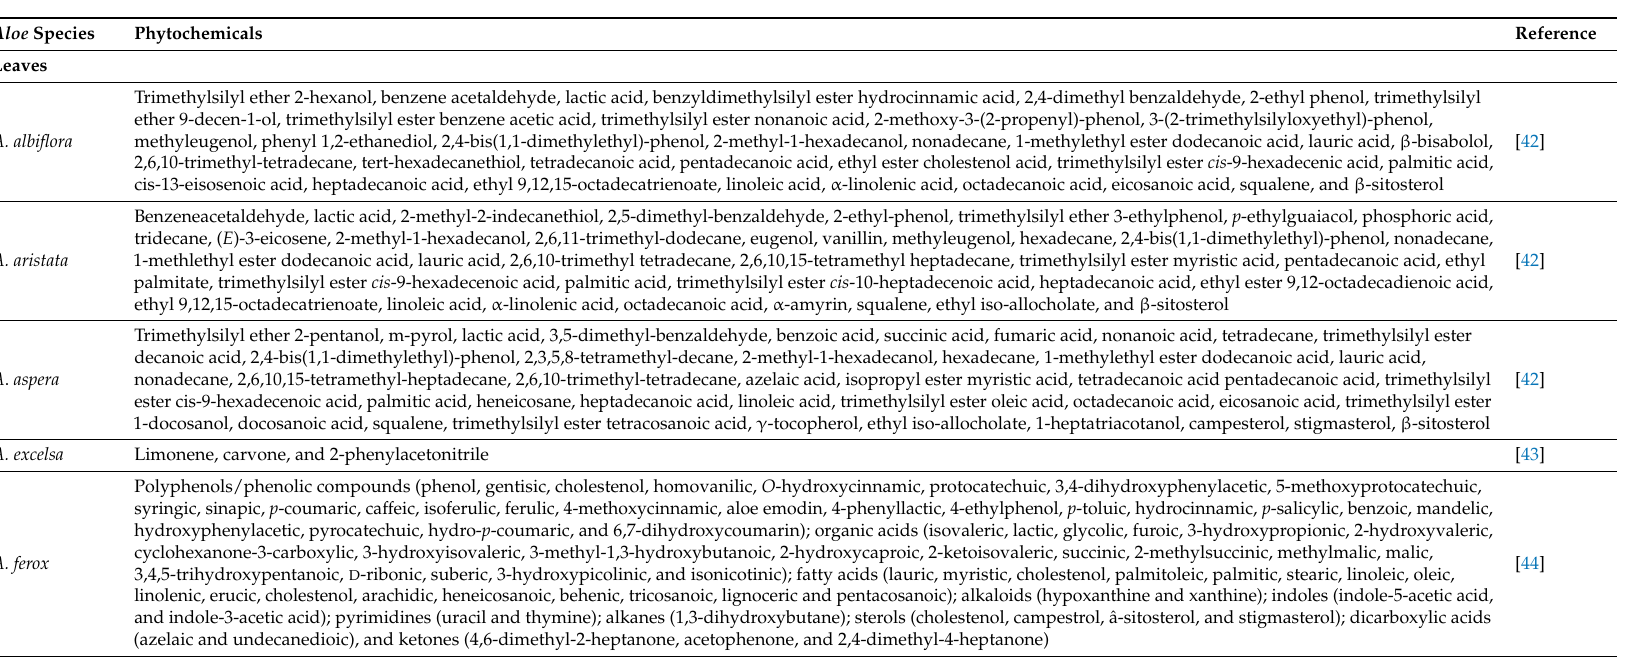
Table 2. Phytoconstituents of Aloe species detected by gas chromatography coupled to mass spectrometry